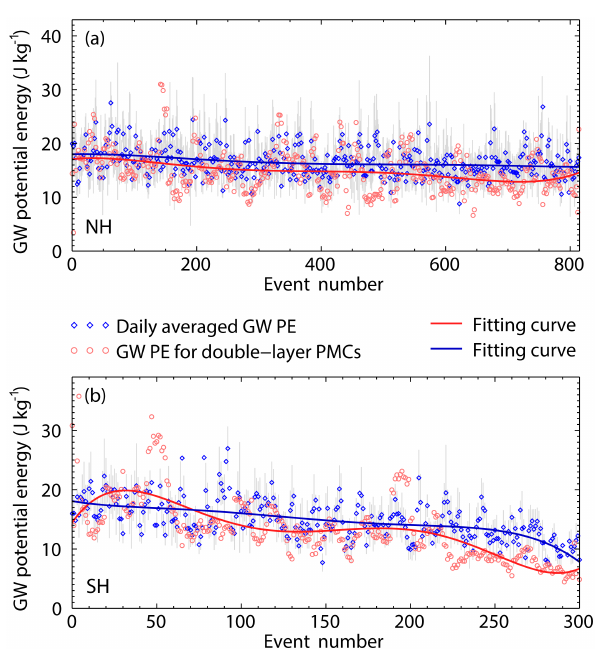
Figure 10. GW potential energy (PE) distributions for double-layer PMCs in the NH (a) and SH (b) . Red denotes the corresponding GW PEs to the double-layer PMCs, while blue denotes the daily averaged GW PEs. Scattered circles are smoothed with a window of 10 events, and grey error bars show the standard deviation of the mean. Curves represent the polynomial fitting